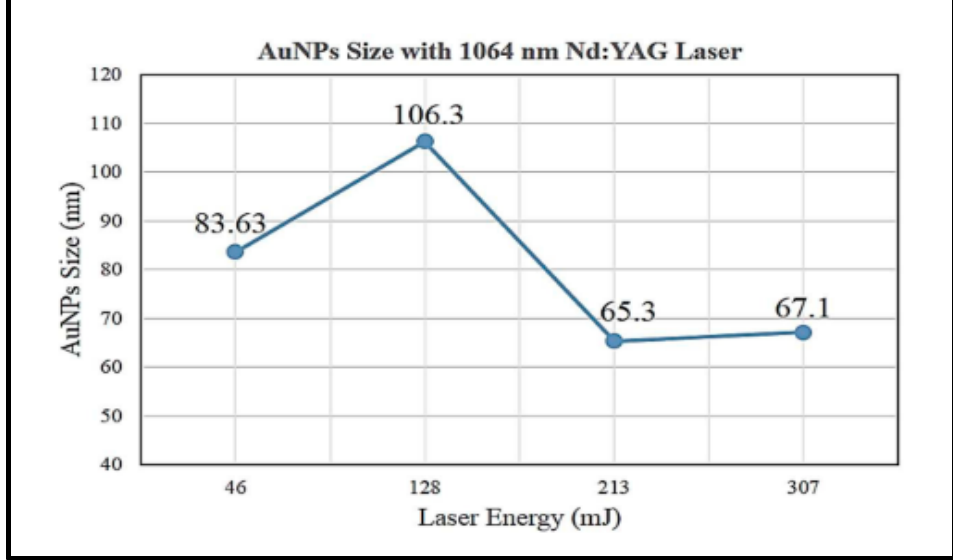
Figure 2. Average size of gold nanoparticles synthesised by 1064 nm wavelength laser ablation at energy of 45, 128, 213 and 307 mJ (retrieved with permission from reference [32]).